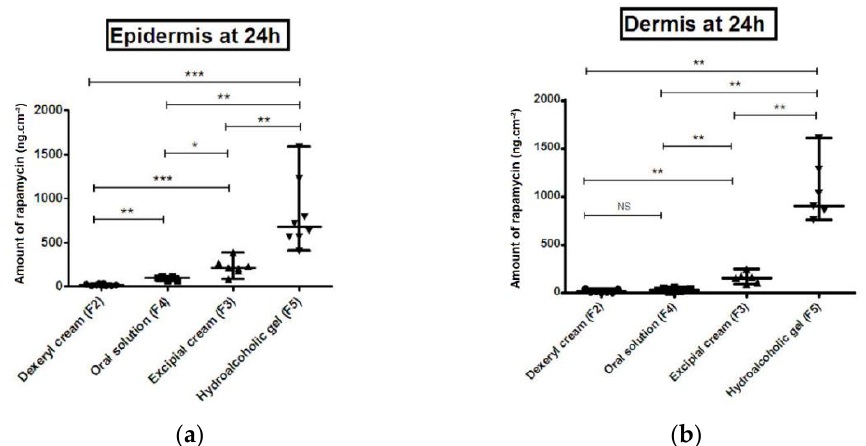
Figure 4. Cumulative amount of rapamycin per unit area (ng cm −2 ) over 24 h from different formulation through epidermis ( a ) and dermis ( b ) of human skin. Data are presented as the median and range. NS: non-significant, * p < 0.05, ** p < 0.01, *** p < 0.001.